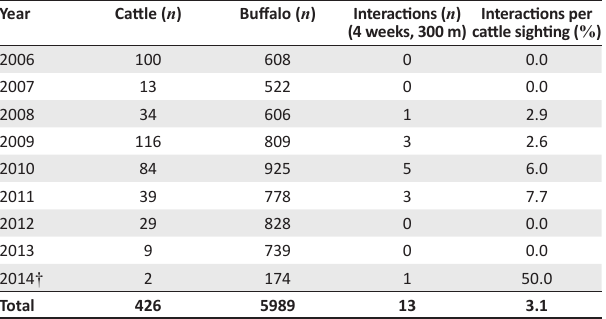
TABLE 1: Number of sightings per year of cattle and buffalo in the Queen Elizabeth National Park in the wildlife crimes database from Uganda Wildlife